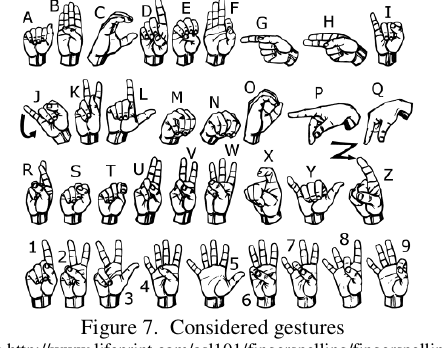
Figure 7. Considered gestures (Source: http://www.lifeprint.com/asl101/fingerspelling/fingerspelling.htm accessed in April 2010)